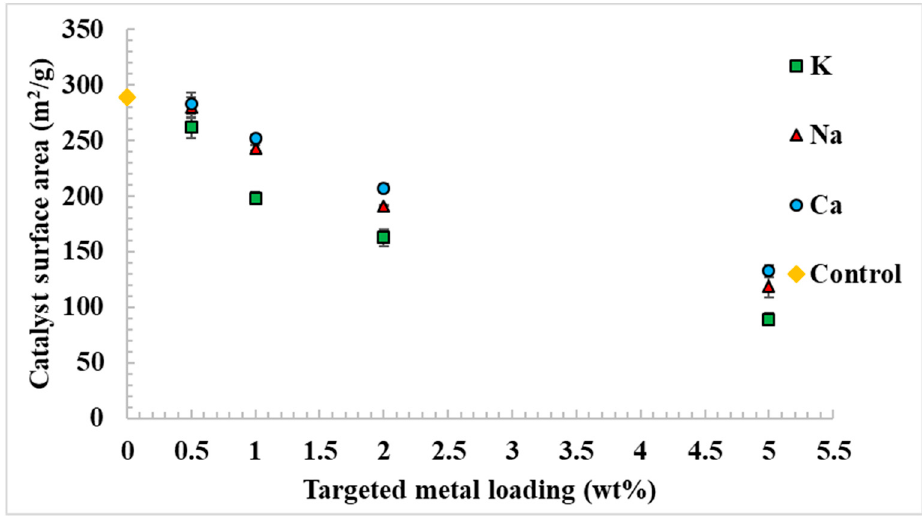
Figure 1. BET surface area of H + ZSM-5 catalyst impregnated with biomass